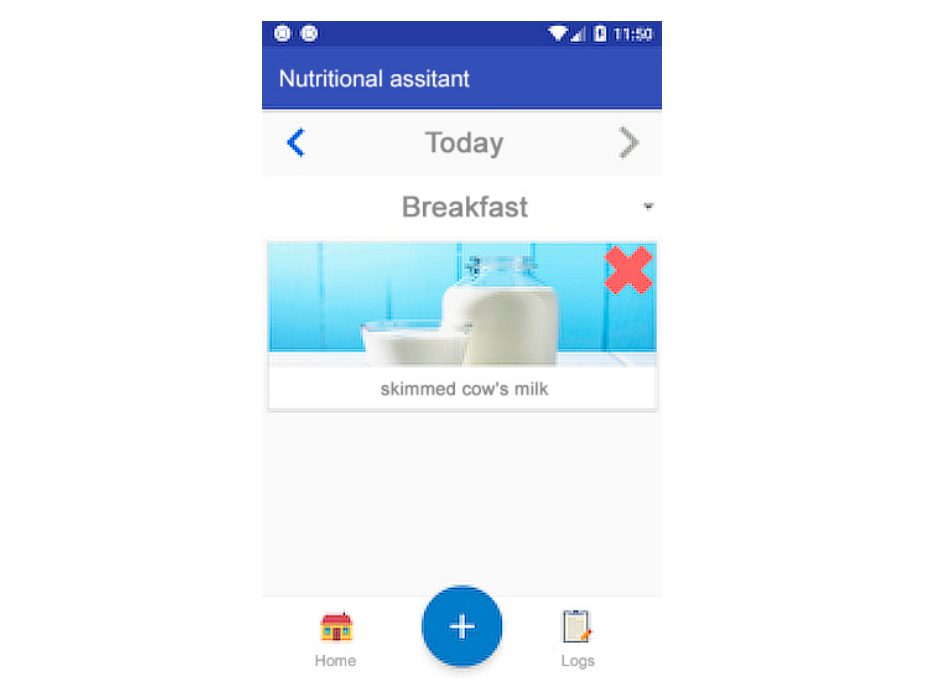
Figure 9. Record display panel.